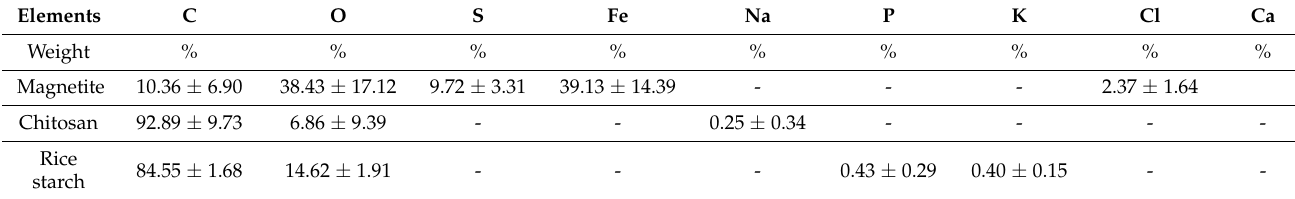
Table 4. EDX results for the magnetite, chitosan, and rice starch.